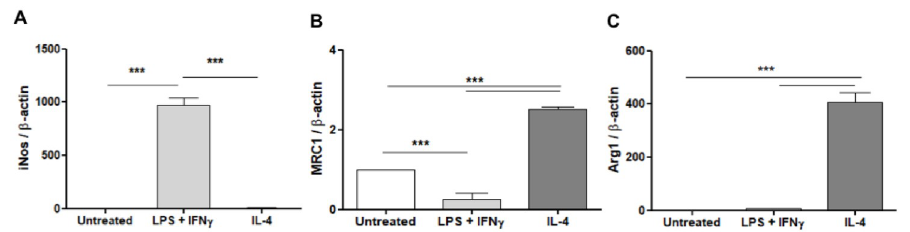
Fig 5. BMDMs polarization analysis. BMDMs were treated with LPS and IFN- γ or IL-4 for 24 hours. The polarization of BMDMs was confirmed by quantitative RT-PCR. (A) iNOS, (B) MRC1, and (C) Arg1 expression levels were normalized by β -actin (mean ± SD). A comparison in each group was performed by one-way ANOVA followed by Tukey-Kramer test ( ��� p < 0.0001).